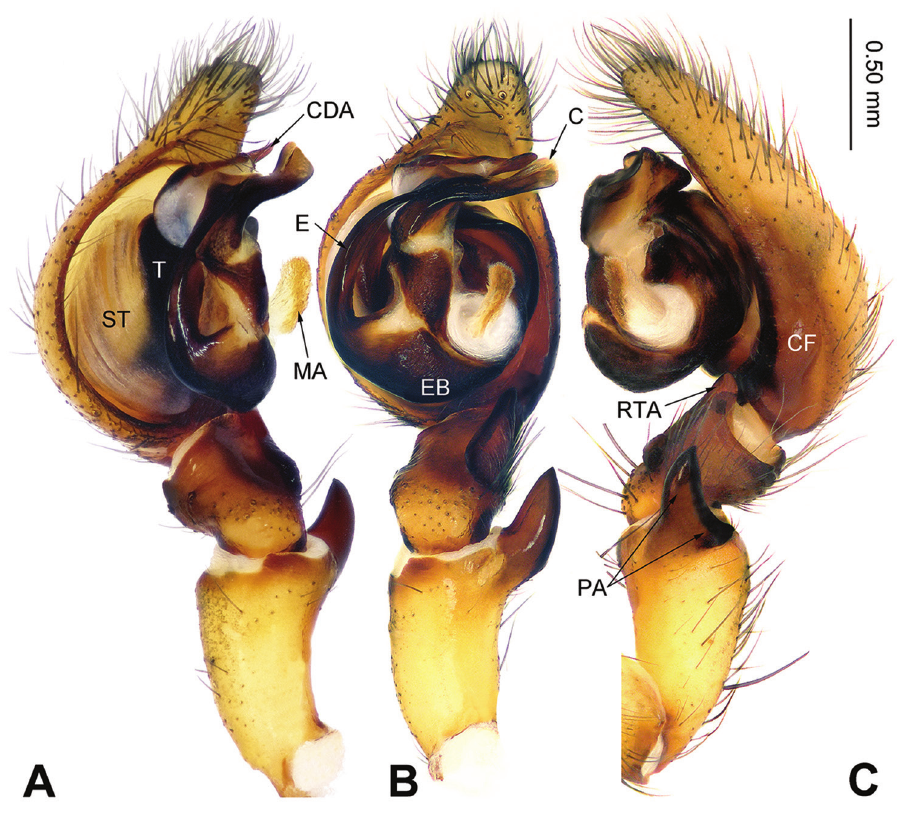
Figure 3. Left male palp of Sinodraconarius cawarongensis sp. n., holotype. A Prolateral view B Ventral view C Retrolateral view. Scale bar equal for A, B, C